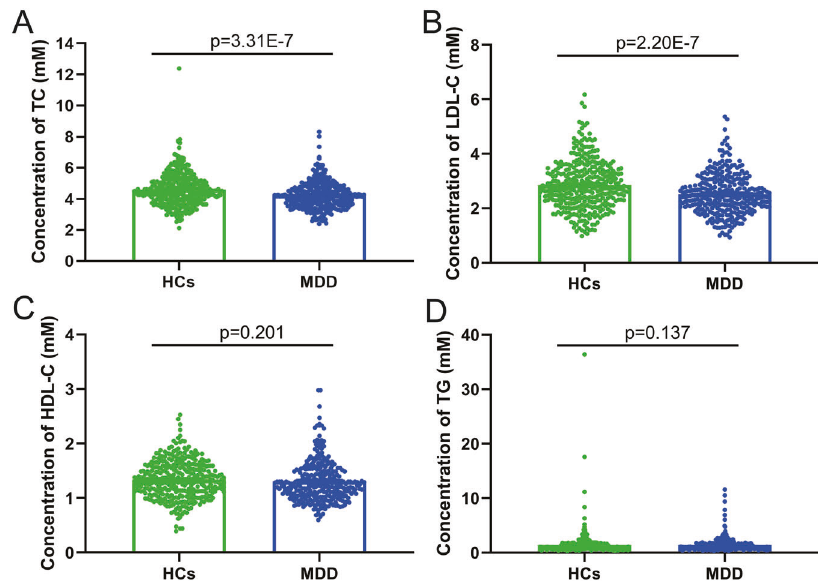
Fig. 1 Serum lipids levels in healthy controls (HCs) and major depressive disorder (MDD) patients. A – D Comparison of serum total cholesterol (TC; A ), low-density lipoprotein cholesterol (LDL-C; B ), high-density lipoprotein cholesterol (HDL-C; C ) and triglyceride (TG; D ) levels between the two groups. Data are presented as mean ±